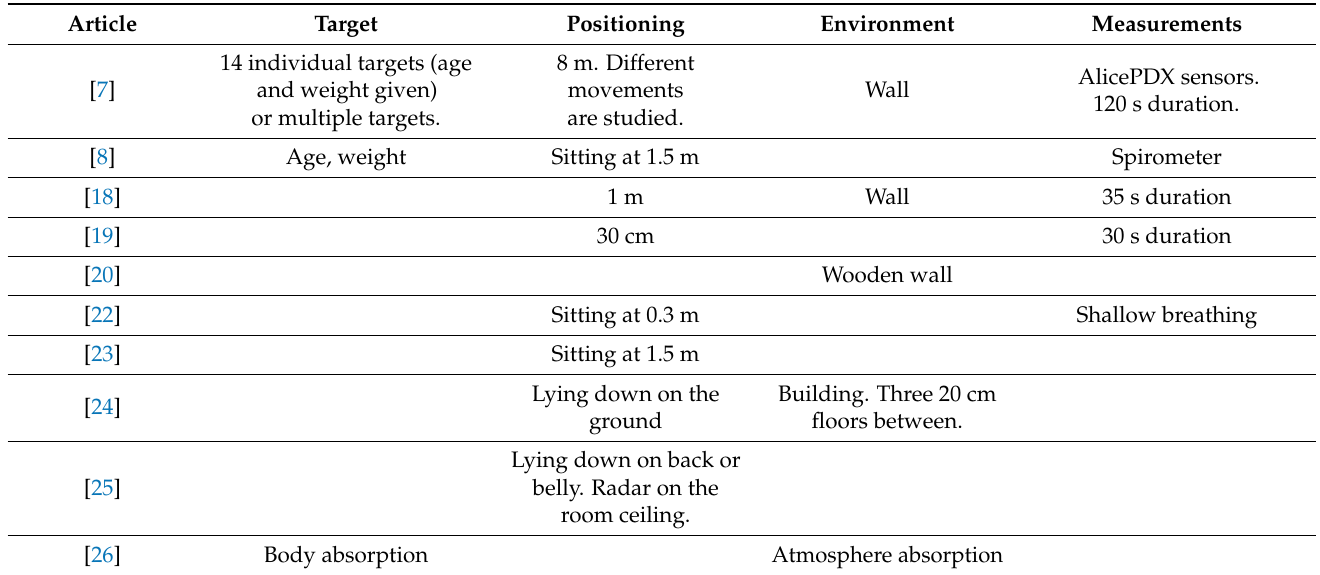
Table 1. Literature review. Articles are cited in the first